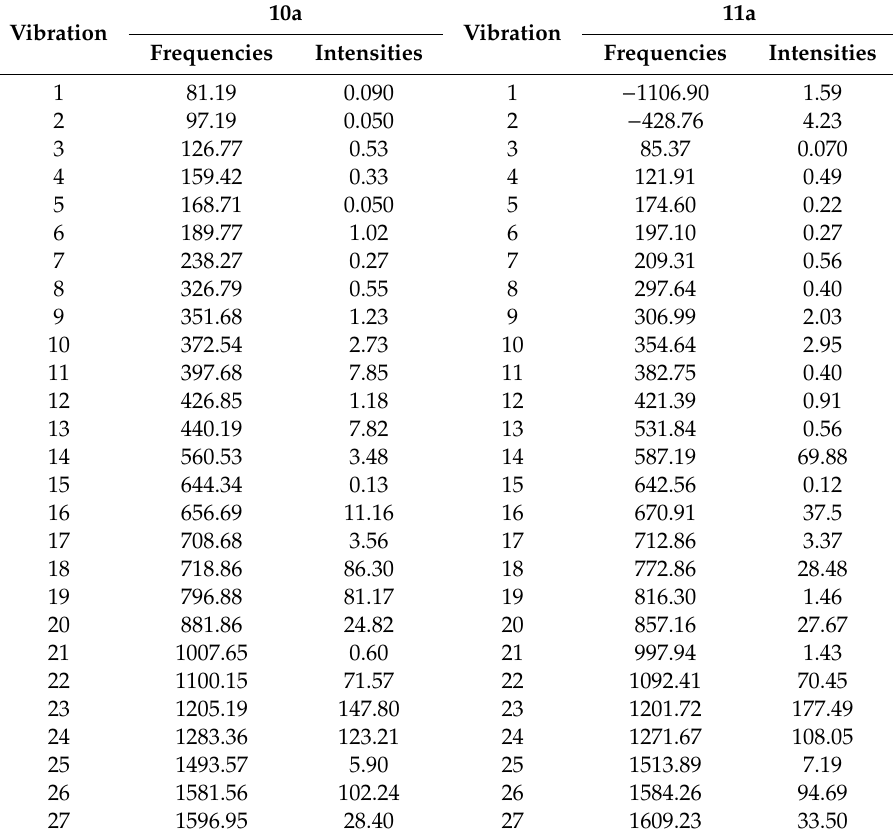
Table 2. Vibrational frequencies calculated for gas phase optimized structures of compounds 10a and 11a calculated with B3LYP // cc-PVDZ(-F). Negative frequencies in the case of compound 11a suggest reactivity of the selenium